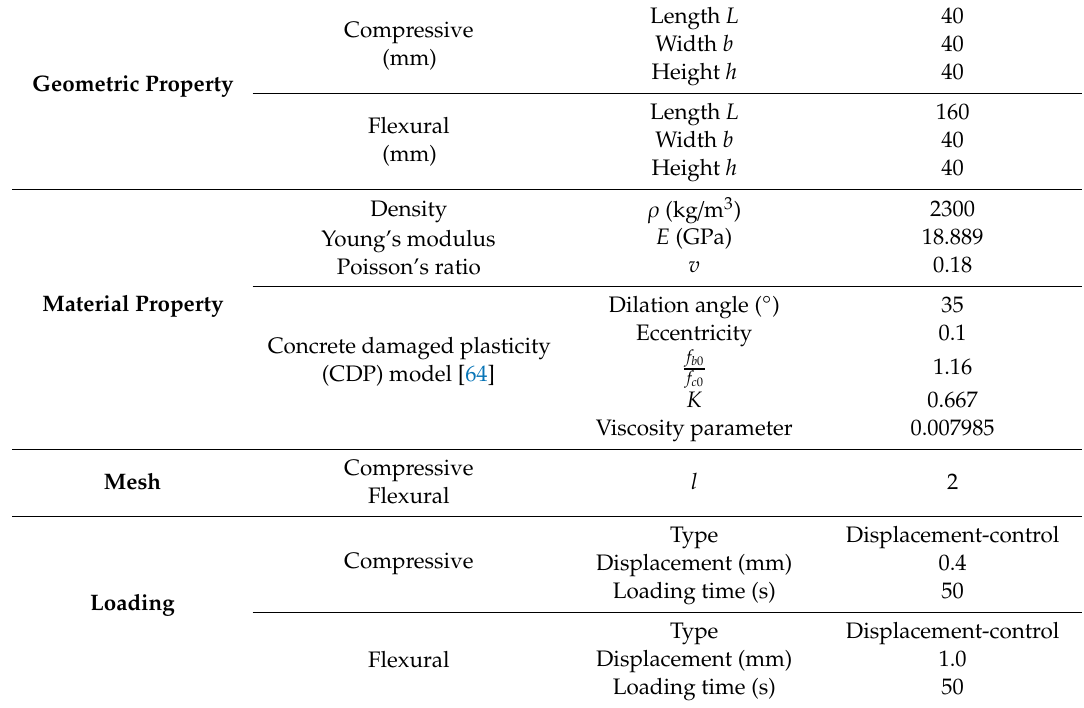
Table 4. Geometric and material properties, as well as the mesh and loading conditions, for the OPC